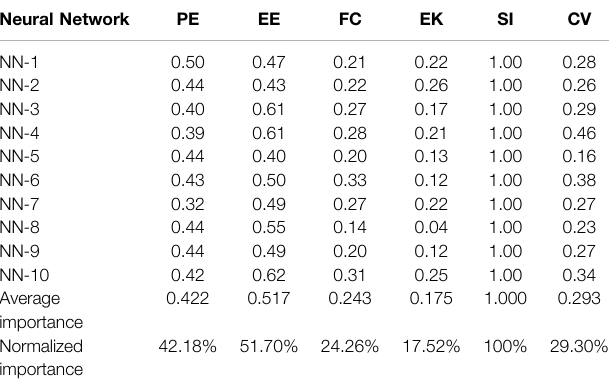
TABLE 9 | Sensitivity analysis (ANN model for BI). Neural Network